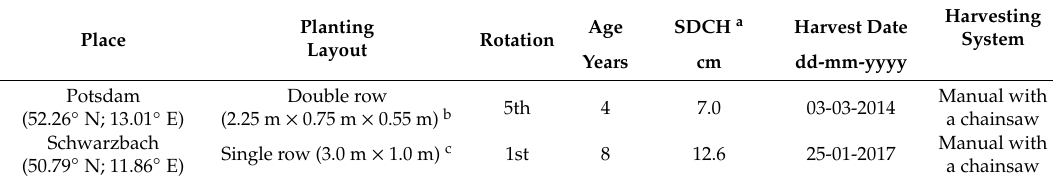
Table 1. Plantation characteristics and harvest